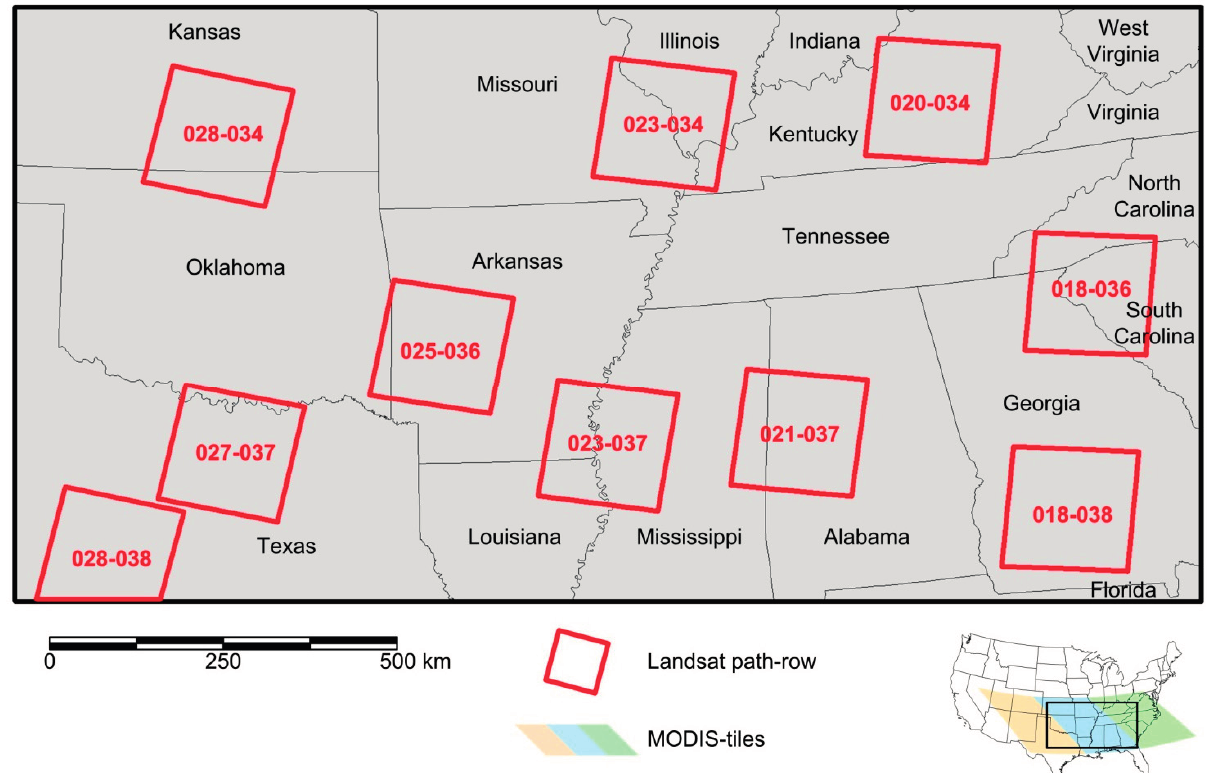
Figure 1. Study area in the southeastern United States, showing MODIS tiles and Landsat